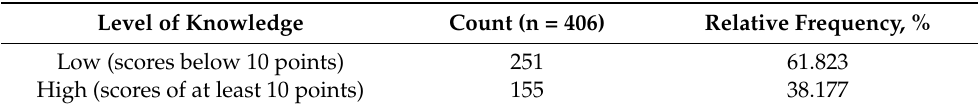
Table 4. Distribution of Respondents according to the Level of Knowledge regarding Analgesics Use During